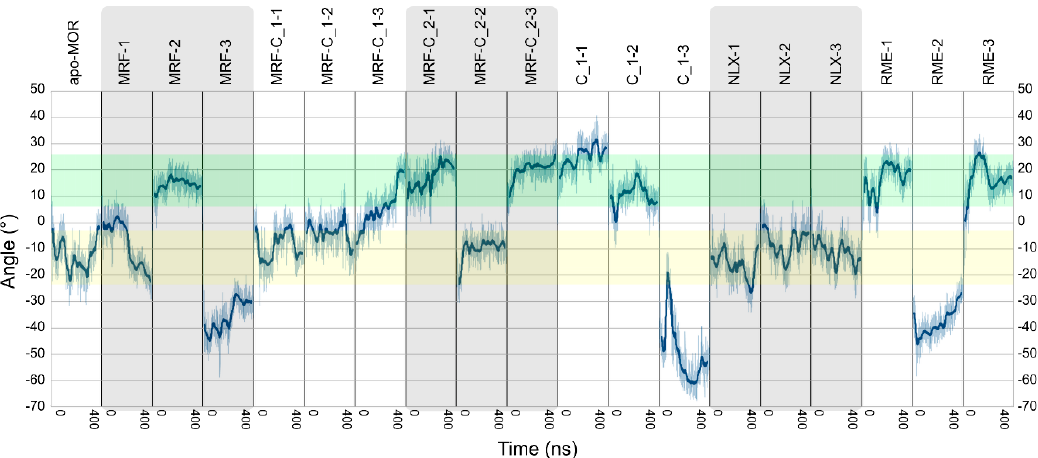
Figure 10. Rotation of intracellular part of TM7, measured below Asn 7.49 residue. Full agonist-like values are highlighted in green, antagonist-like values highlighted in yellow. Transparent line represents actual values, opaque thick line was added to facilitate analysis and represents a moving average.